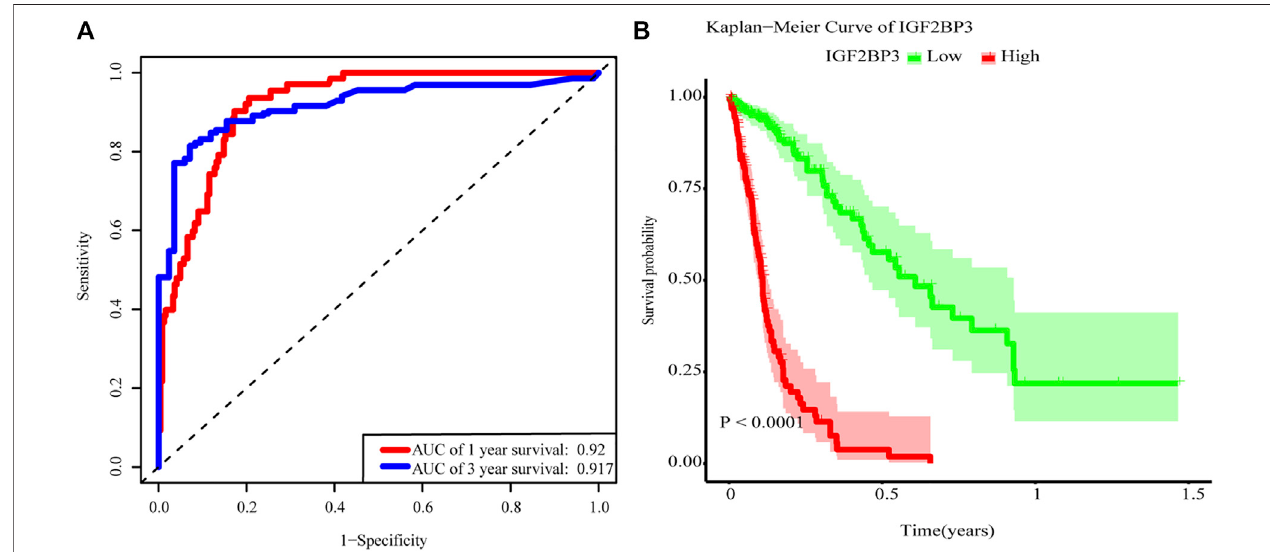
FIGURE6| m 6 A-relatedgenemodelinprognosis. (A) ROCcurves.AUC (cid:1) 0.92for1-year(blue)andAUC (cid:1) 0.917for3-yearssurvival(red). (B) Overallsurvivalwas analyzed in high (red) or low (blue) expression of IGF2BP3 in the TCGA glioma dataset. The p value was generated from the log-rank test.